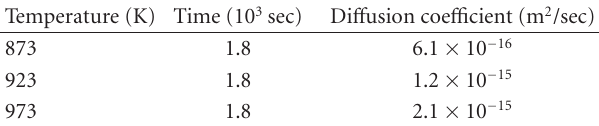
Figure 3: Penetration profiles (ln C versus x 2 ) derived from depth profiles of nitrogen obtained after annealing at di ff erent temperatures in D9 steel. Table 2: Di ff usion coe ffi cients of N in D9.